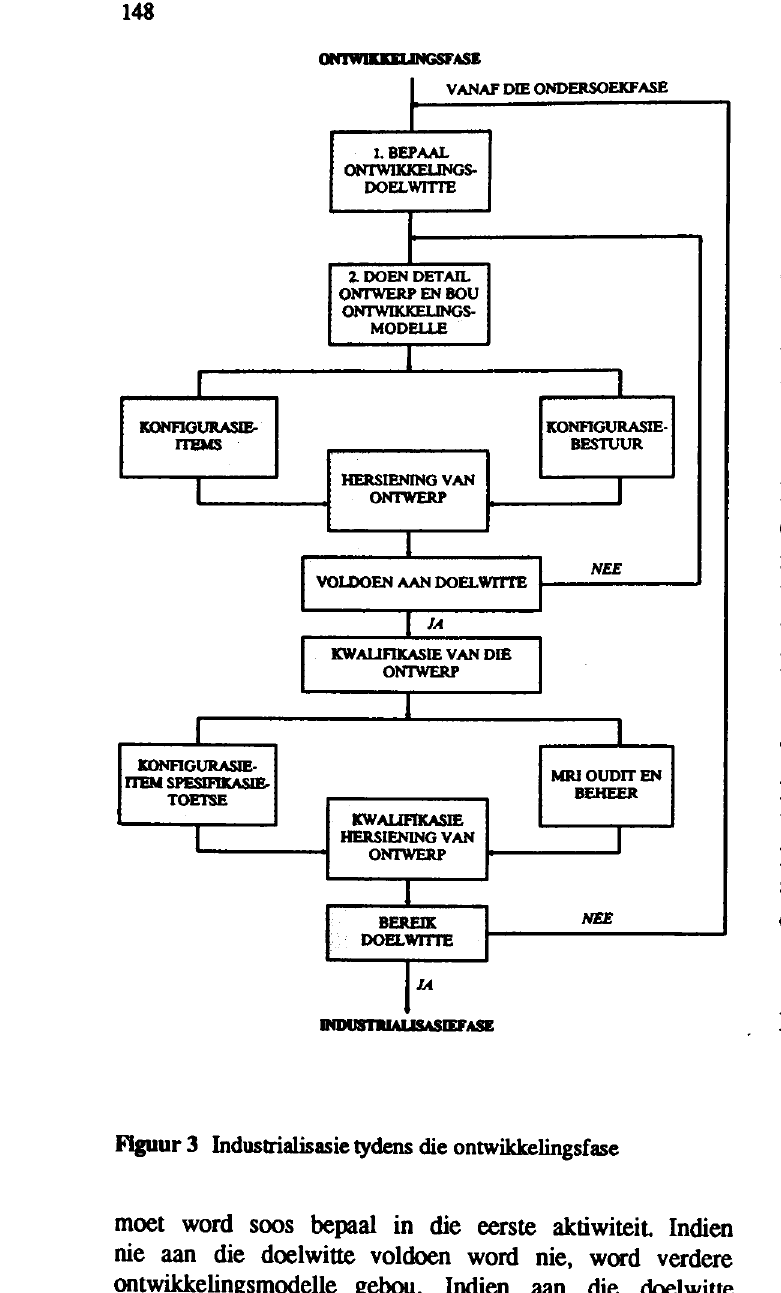
Flguur 3 lnduslrialisasie tydens die ontwikkelingsfase moet word soos bepaal in die eerste aktiwiteit Indien nie aan die doelwitte voldoen word nie, word verdere ontwikkelingsmodelle gebou. Indien aan die